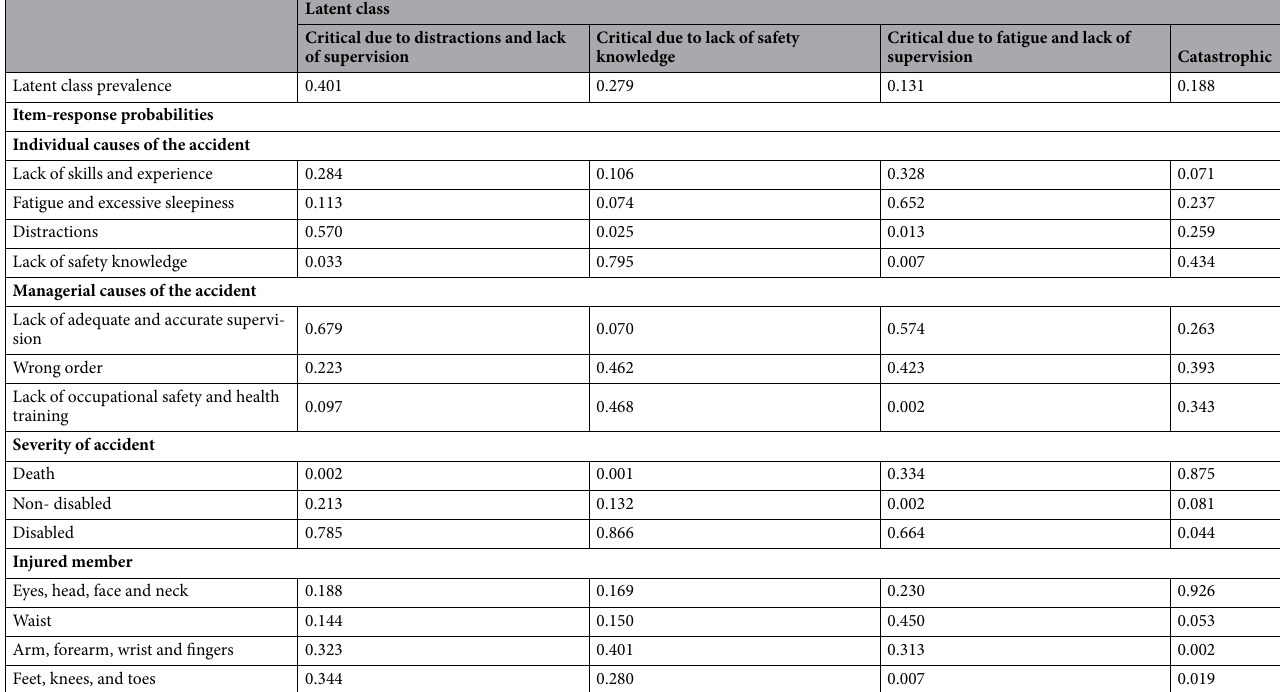
Table 3. The four latent class models of occupational accidents in industry workers. The probability of a “No” response can be calculated by subtracting the item-response probabilities shown above from 1. *Item-response probabilities > .5 in bold to facilitate interpretation.